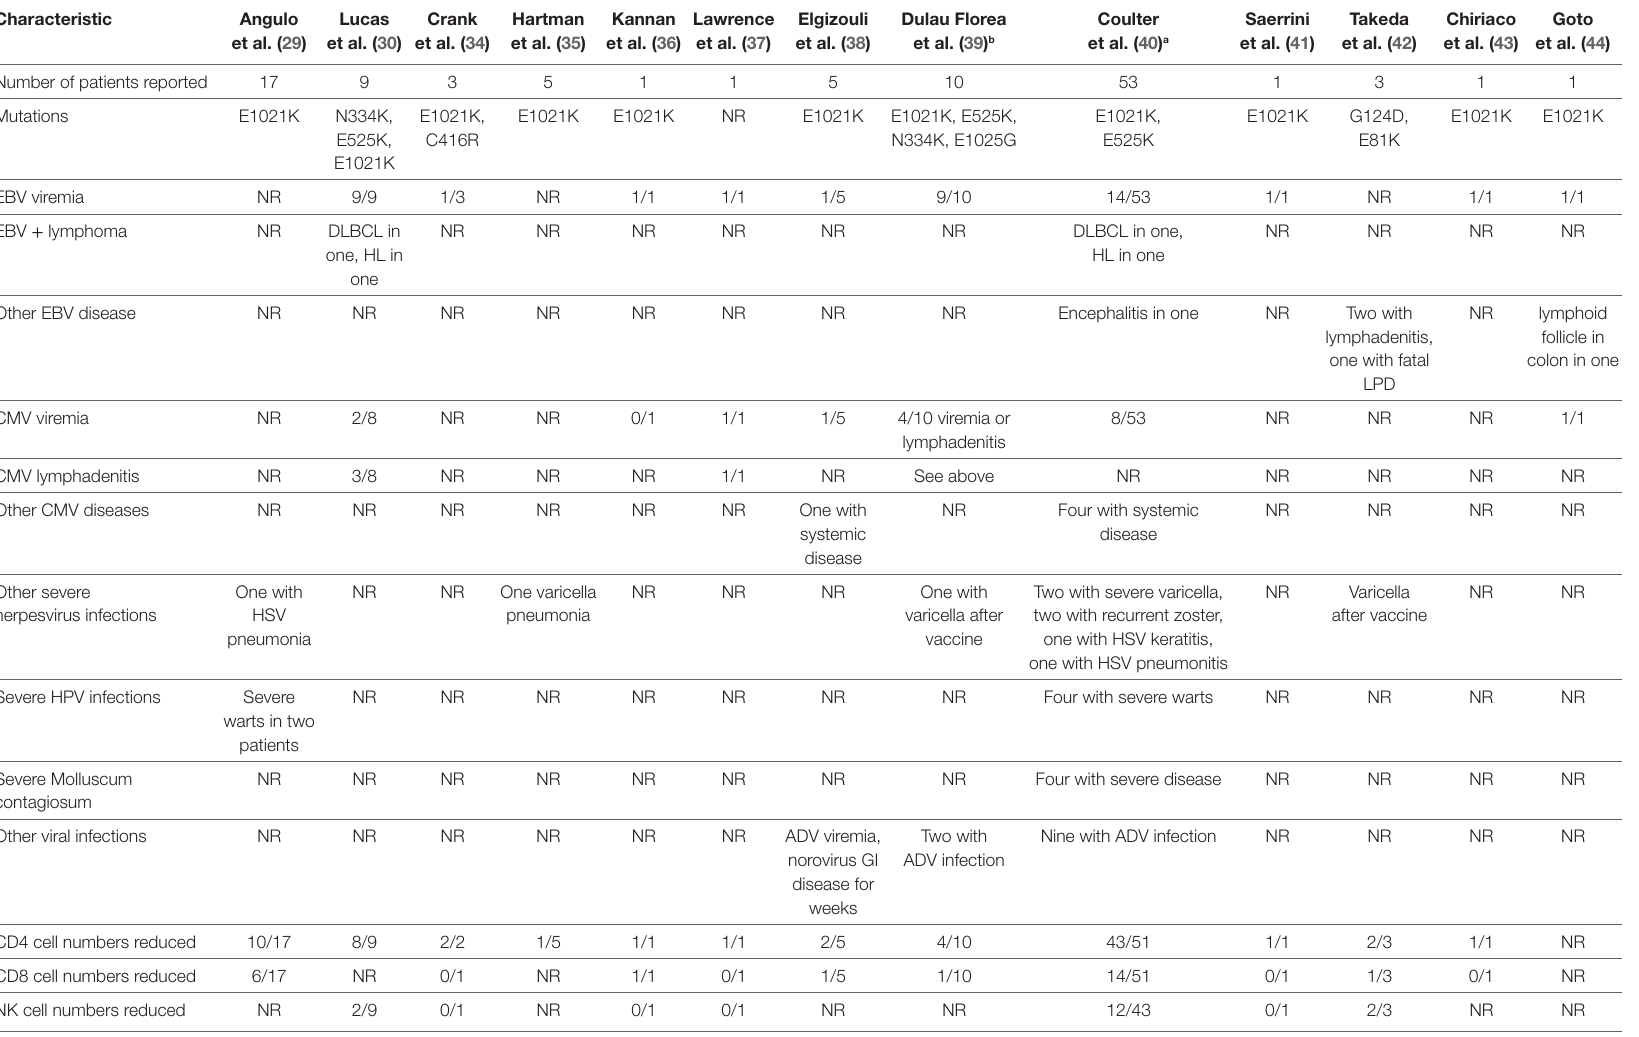
Lucas Crank Hartman Kannan Lawrence et al. (29) et al. (30) et al. (34) et al. (35) et al. (36) et al. (37)